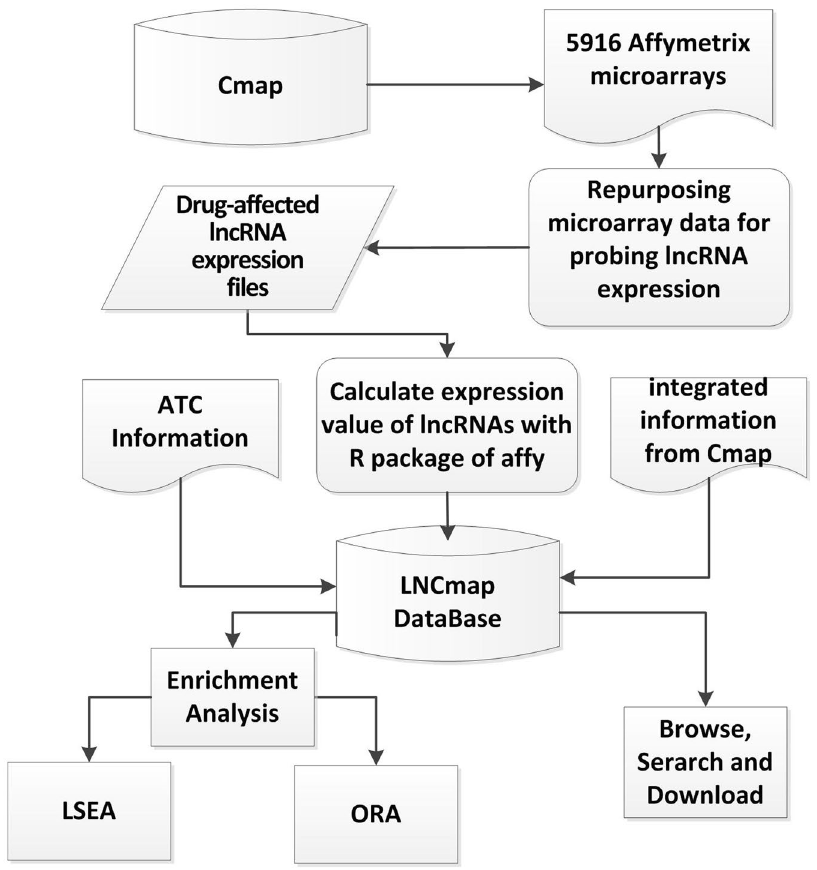
Figure 1. Schematic data flowchart of